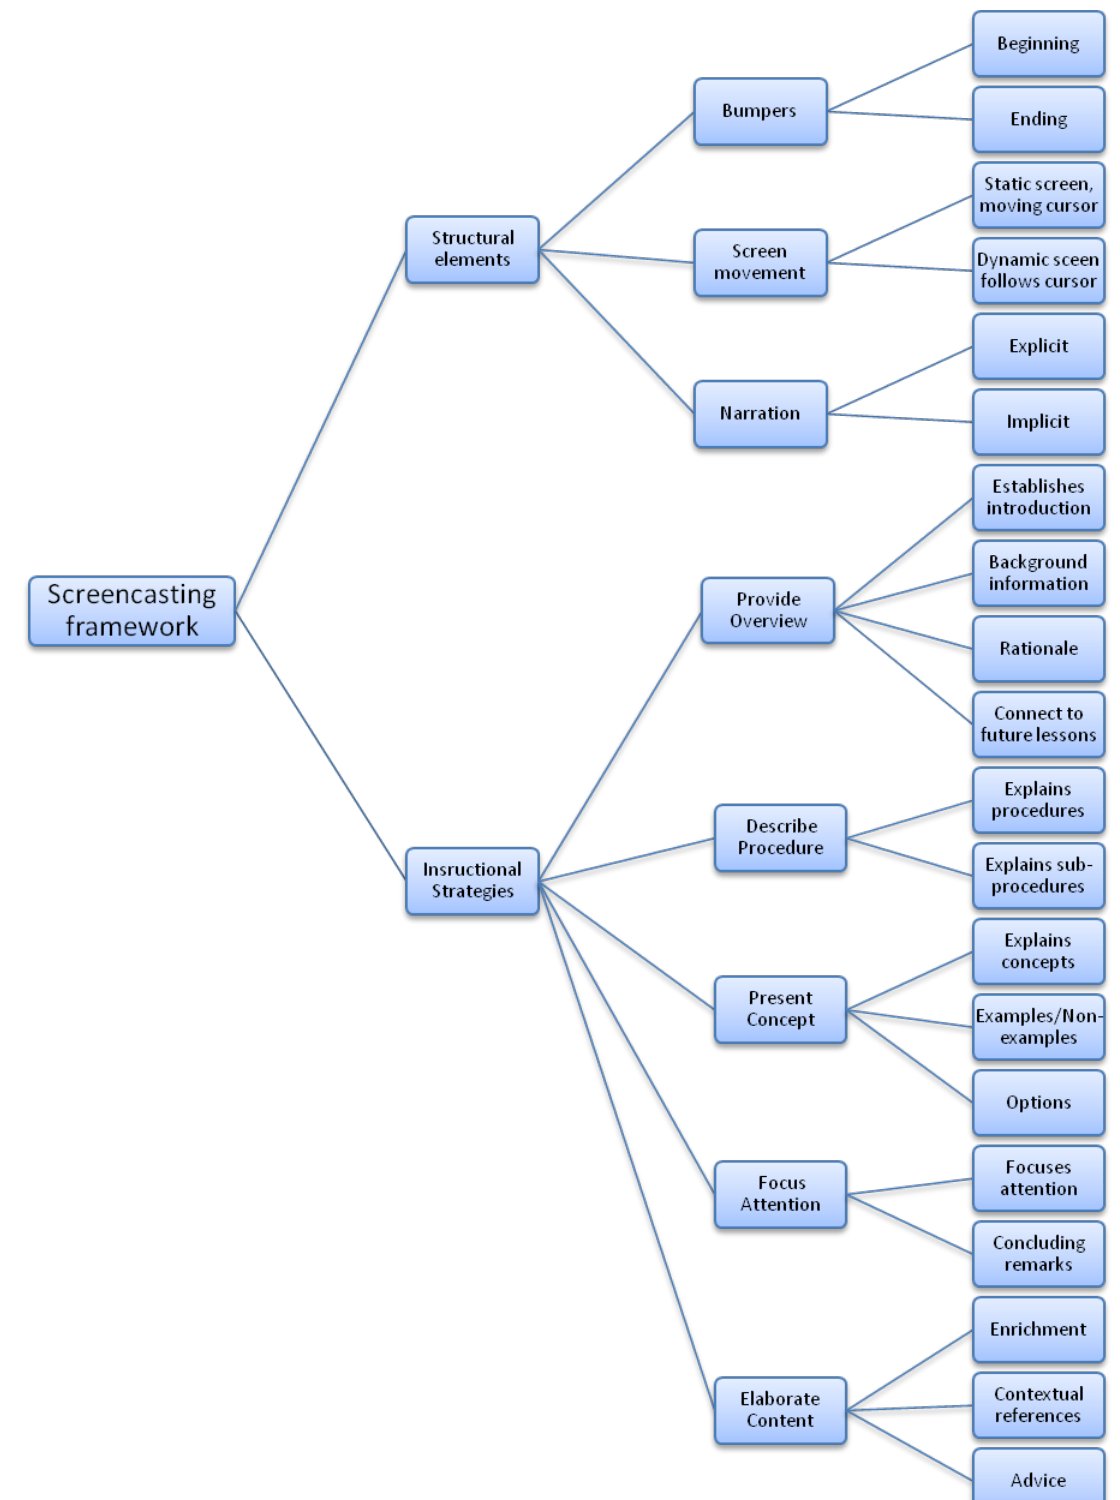
Figure 1. Screencasting framework and corresponding instructional